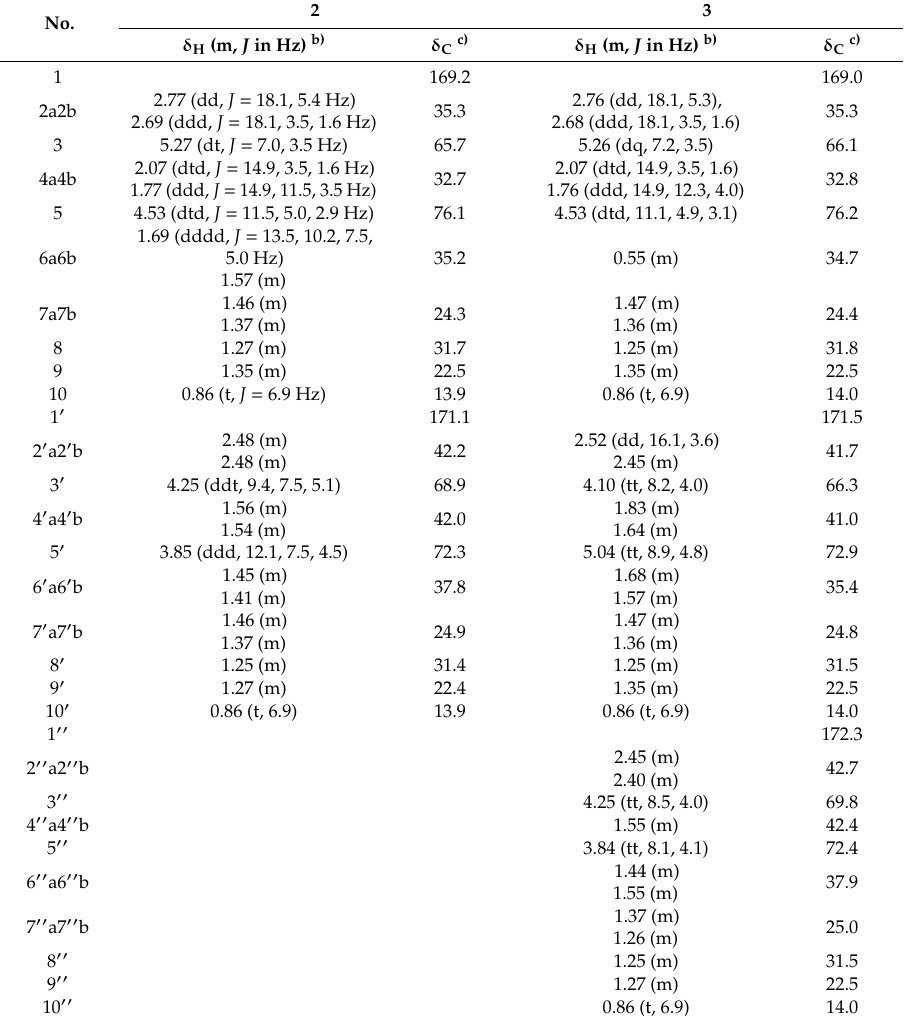
Table 1. 1 H and 13 C-NMR data of 2 and 3 ( δ values).